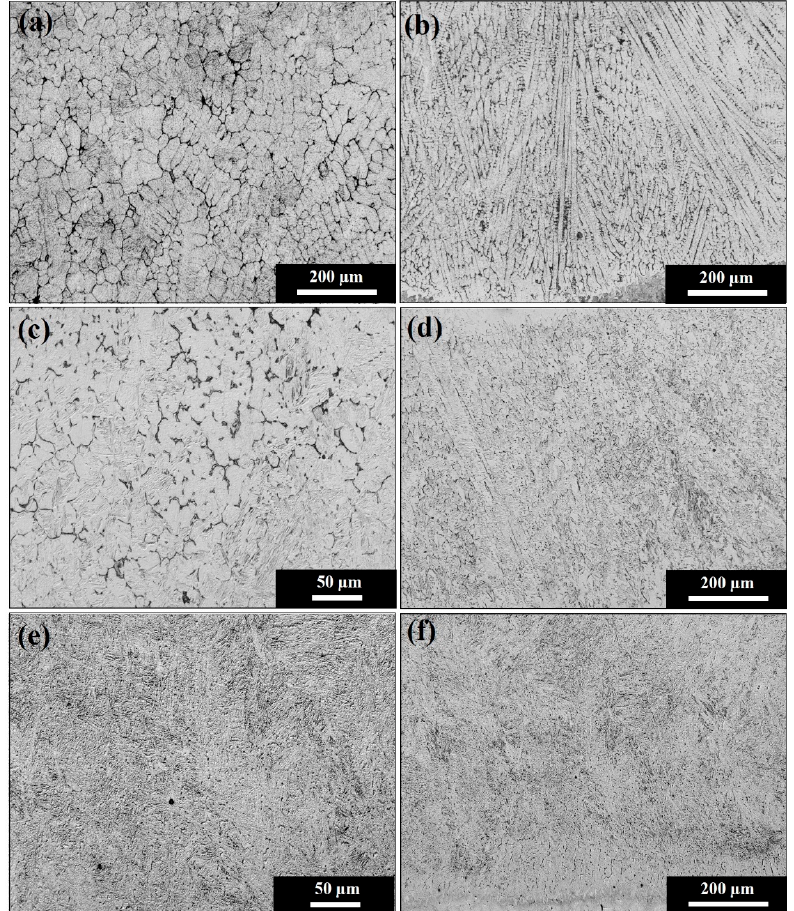
Figure 4. Microstructure of the cladding showing ( a ) equiaxed martensite at the surface of the untempered rail, ( b ) dendritic martensite at the interface. The 350 °C tempered cladding deposition contains ( c ) partially tempered equiaxed martensite at the surface and ( d ) partially tempered dendritic martensite at the interface. The 540 °C heat treatment produces a fully tempered martensitic structure at both the ( e ) surface and ( f ) interface.